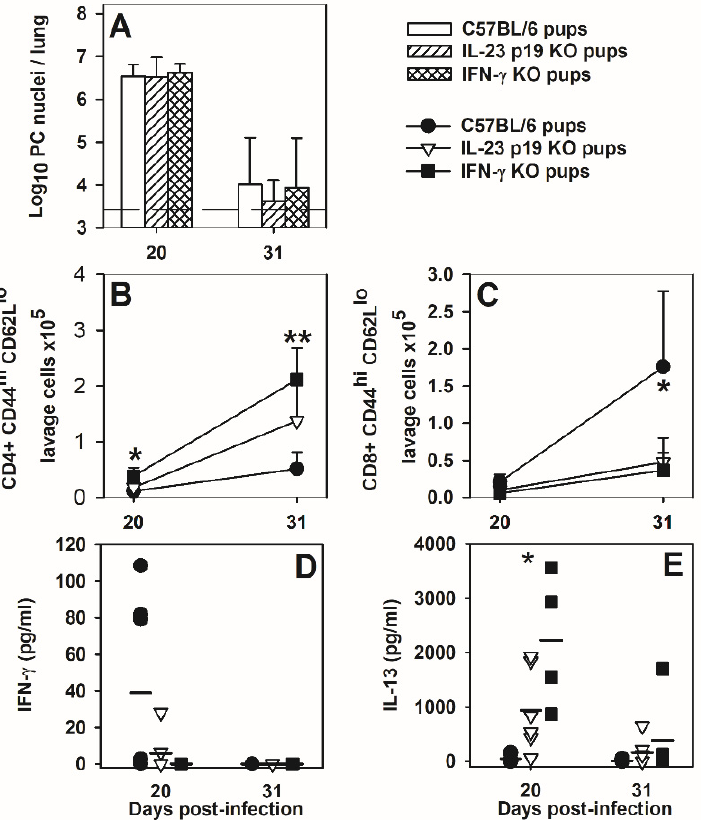
Figure 9. Mice deficient in IFN γ or IL-23p19 clear P. murina with the same kinetics as wild type mice. Neonatal mice were infected with intranasal inoculations of 10 6 organisms and examined at days 20 and 31 post inoculation for ( A ) lung organism burden determined microscopically, ( B , C ) = alveolar activated T cell numbers measured by flow cytometry, and ( D , E ) cytokine concentrations in the lung lavage fluid measured by ELISA. Data represents the mean ± SD of 4–8 mice ( A – C ) or individual mice with the mean shown ( D , E ). ** p < 0.05 knockout mice compared to C57BL/6 mice, * p < 0.05 IFN ϒ − / − mice compared to C57BL/6 mice.